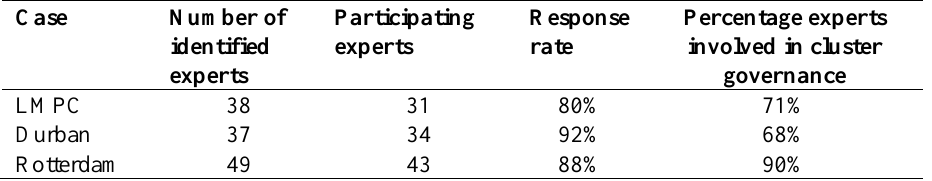
Table 2. Selection of port experts